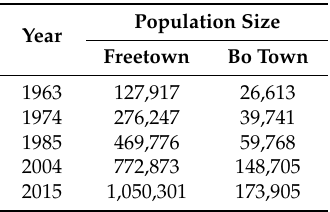
Table 2. Census-based population growth in Freetown and Bo